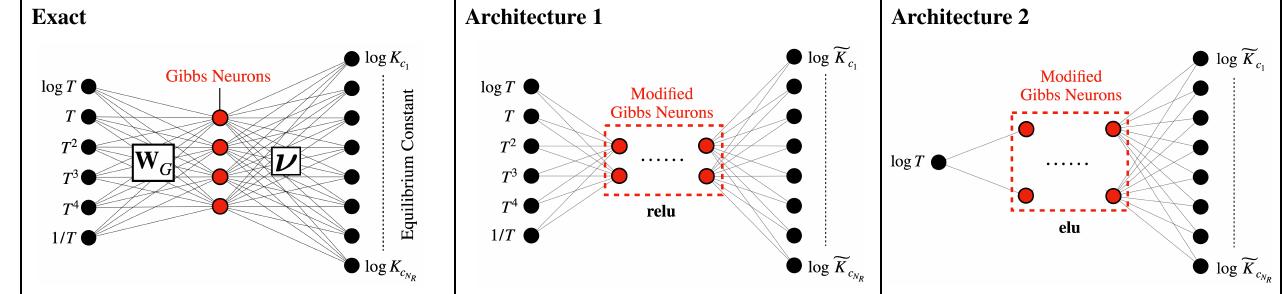
Figure A1. Illustrations of ANN representations for log ( K c ) : ( Left ) exact ANN (same as Figure 1c); ( Middle ) approximate ANN, Architecture 1; and ( Right ) approximate ANN, Architecture 2. The number of modified Gibbs neurons changes through N H and N L ( N H = 2 here for illustrative